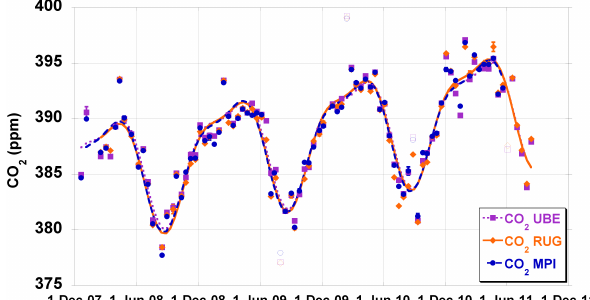
Fig. 2. CO 2 concentration at Jungfraujoch, Switzerland from flask samples measured by three laboratories: University of Bern (UBE) (pink squares), University of Groningen (RUG) (orange diamonds) and Max Planck Institute in Jena (MPI) (blue circles). The values are the averages of 1, 2 or 3 flasks. The fits through the data are lin- ear trends plus double harmonic seasonal components. Open sym- bols represent those values that are outliers to the fit of the individ- ual data set (based on the 2.7 sigma exclusive filter on the residuals). The error bars represent the standard error of the average value of 2 or 3 flasks. For single flask measurements error bars are not shown.